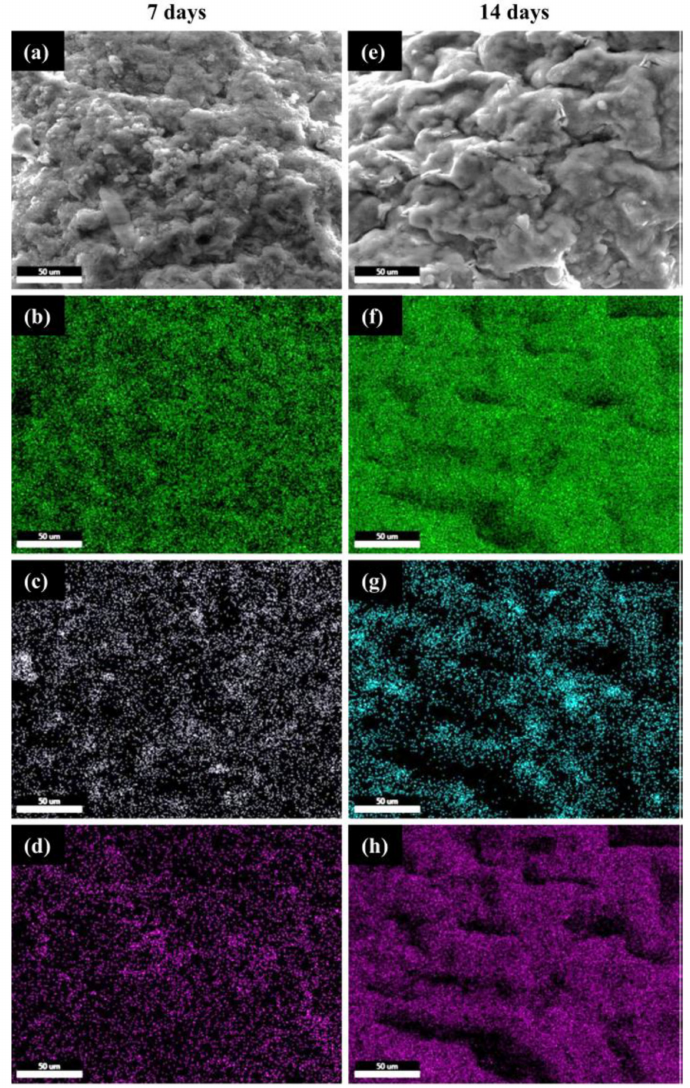
Figure 6. SEM / EDX micrographs with the elemental mapping for CS–FG3 sca ff olds after 7 and 14 days of immersion in SBF (scalebar 50 µ m): ( a , e ) SEM micrographs representative for the investigated areas, ( b , f ) Ca mapping, ( c , g ) Si mapping, and ( d , h ) P